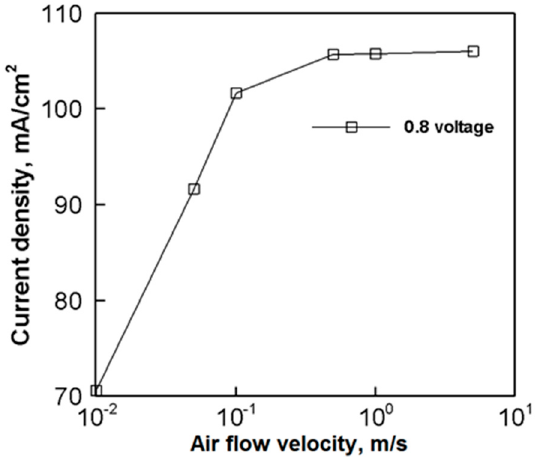
Figure 8. Effect of air flow velocity on current density.